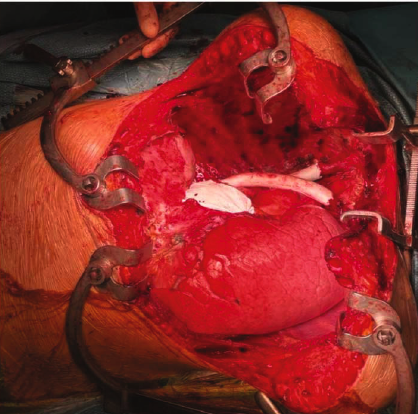
Figure 2: Giant thymoma resected en bloc with the right lung and ipsilateral parietal pleura. The specimen measured 236mm × 214 mm × 114mm .